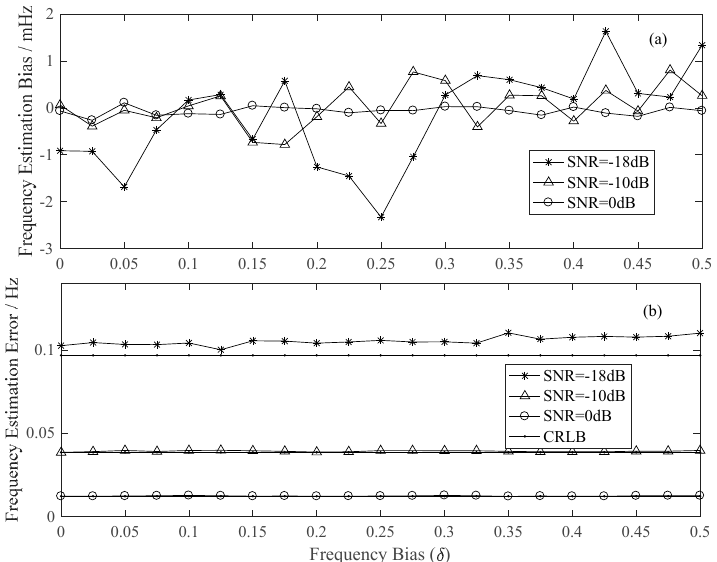
Figure 3. The estimation performance of proposed method under different SNR situations, ( a ) Fre- quency estimation bias, ( b ) Frequency estimation error.